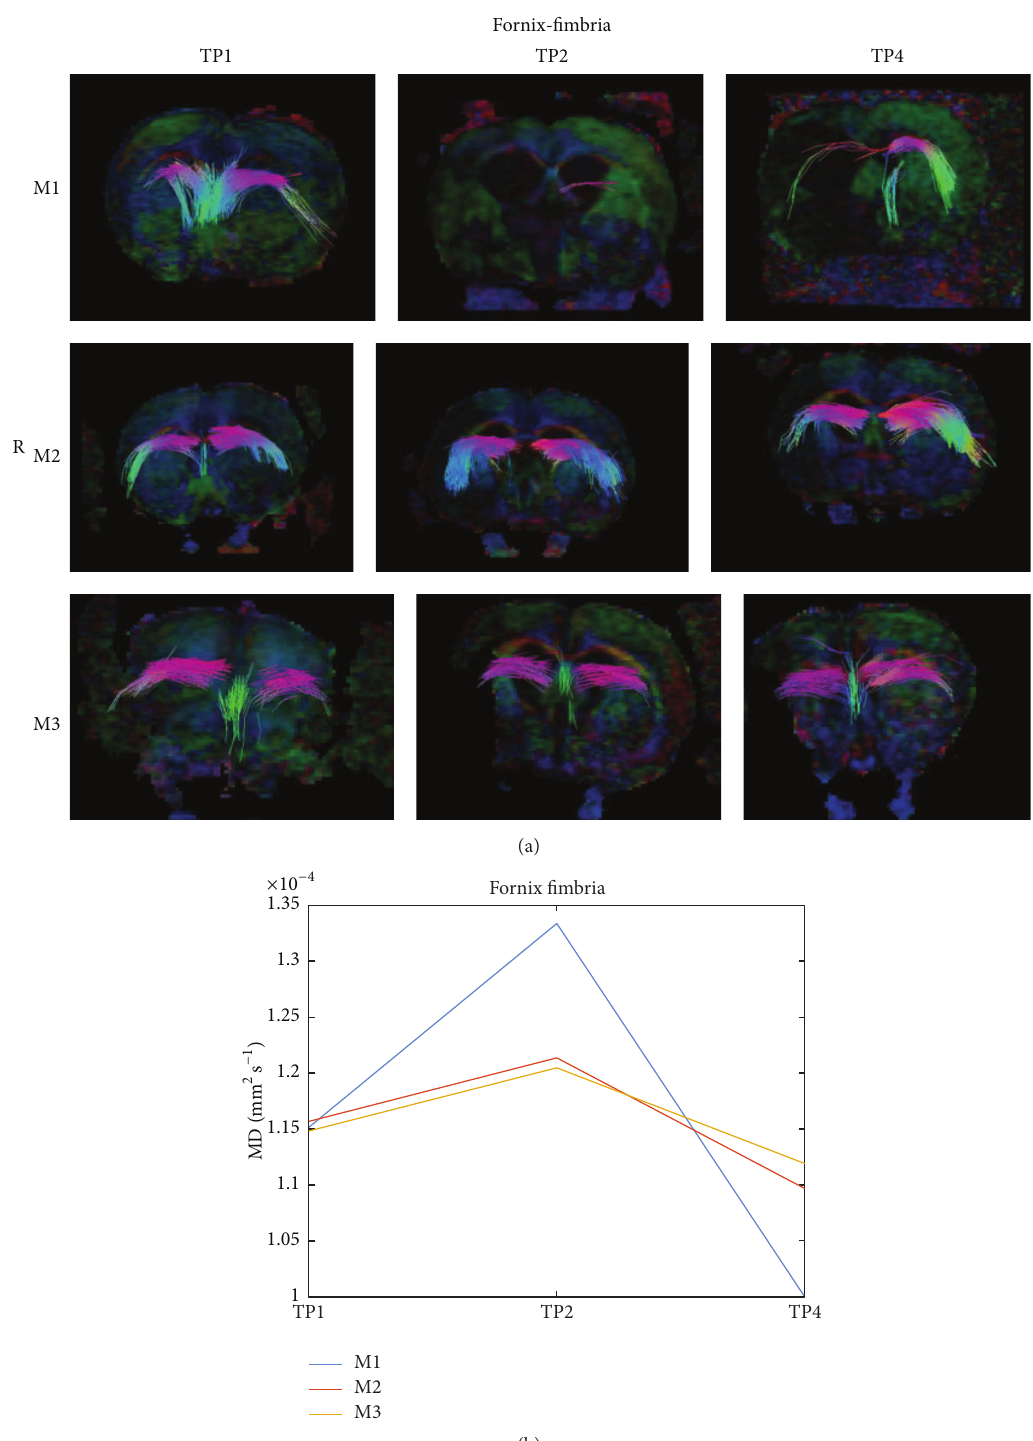
Figure 7: DTI of fornix-fimbria. A reconstruction of the fornix-fimbria white matter system (a) of the 3 examined rat groups (M1, M2, and M3 as described in Figure 4) at 3 time points (TP1, TP2, and TP4 as described in Figure 4). The median diffusivity of the fiber system was extracted and is shown in